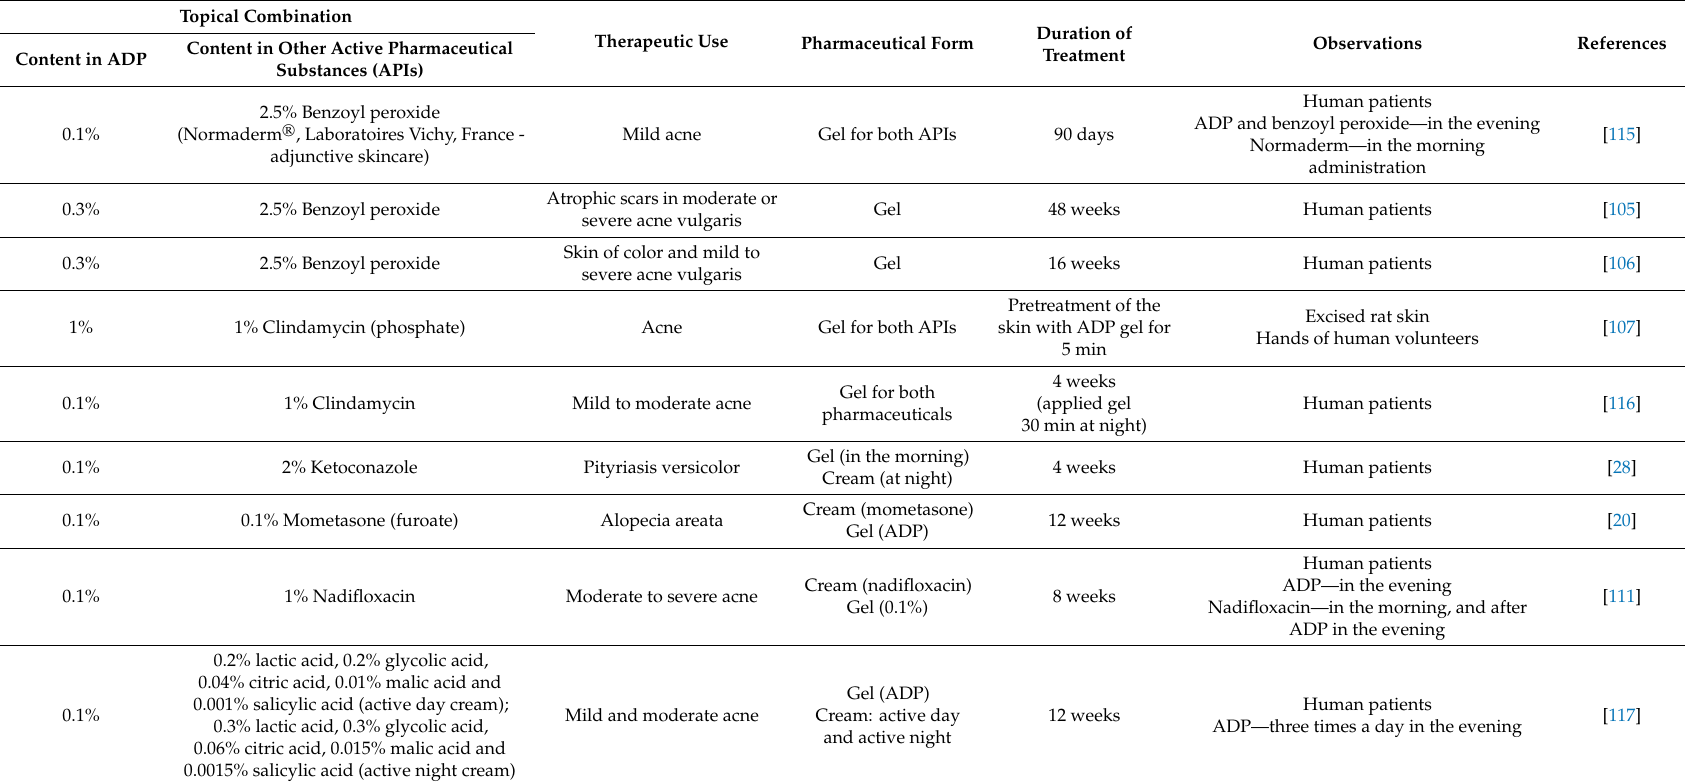
Table 5. The most used active pharmaceutical ingredients (APIs) in topical combinations with adapalene